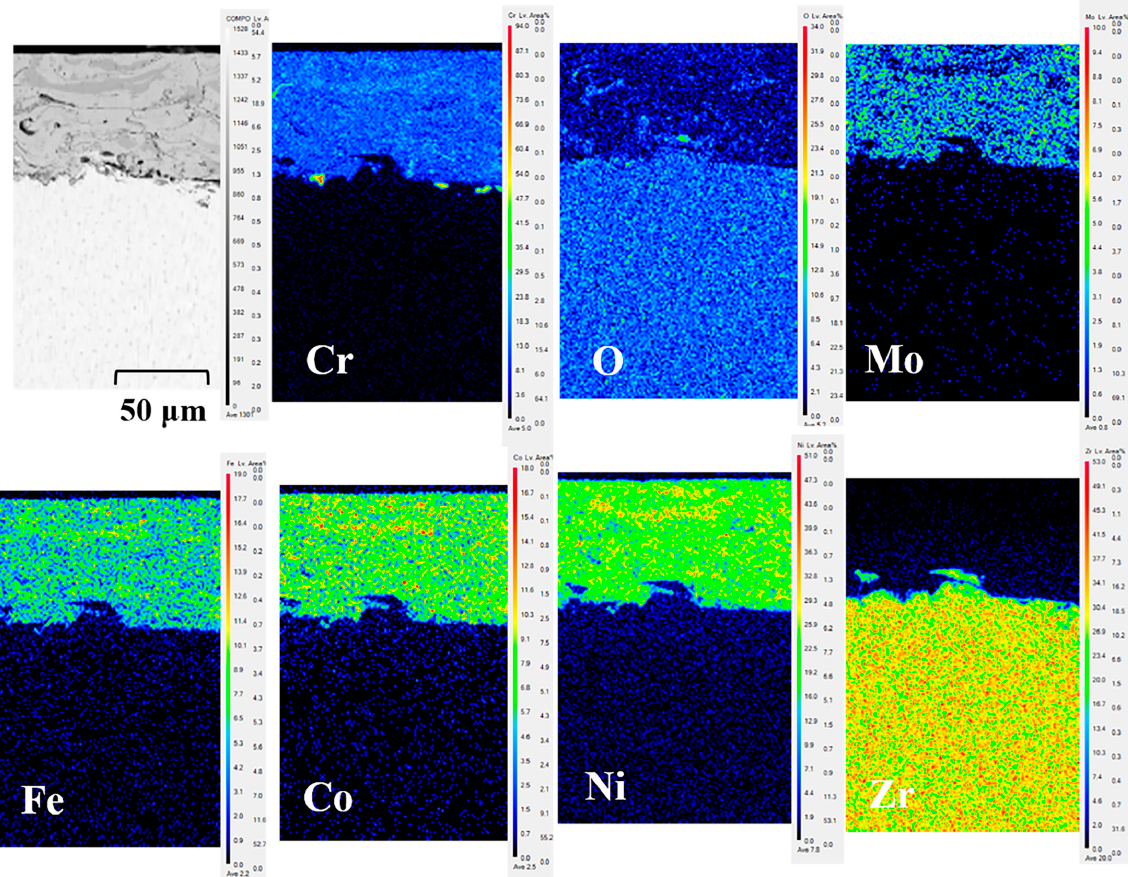
Figure 3. EPMA elemental mapping of the FeCoNiCrMo coatings on the zircaloy ‐ 4 substrates.